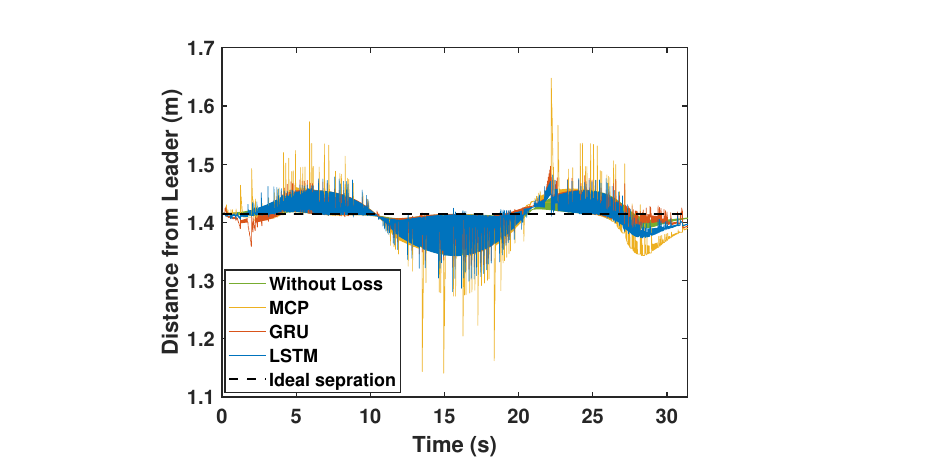
Figure 13. Distance of the follower from the leader for the circular trajectory (packet loss—30%). The formation control experiment along the eight-shaped trajectory was repeated with 50% packet loss. As illustrated in Figure 14, LSTM again outperformed GRU and MCP in terms of prediction. The distance from the leader is depicted in Figure 15. MCP had a weaker performance compared to LSTM and GRU. The RMSE for the X, Y, and heading angle of the follower is presented in Table 4 for the 50% packet loss scenario. As observed earlier, LSTM outperformed GRU and MCP. LSTM’s prediction performance is comparable with that in a perfect communication scenario (0% packet loss) even when sustaining 50% packet loss. Overall, LSTM performed 14.49% better than GRU and 250.53% better than MCP.